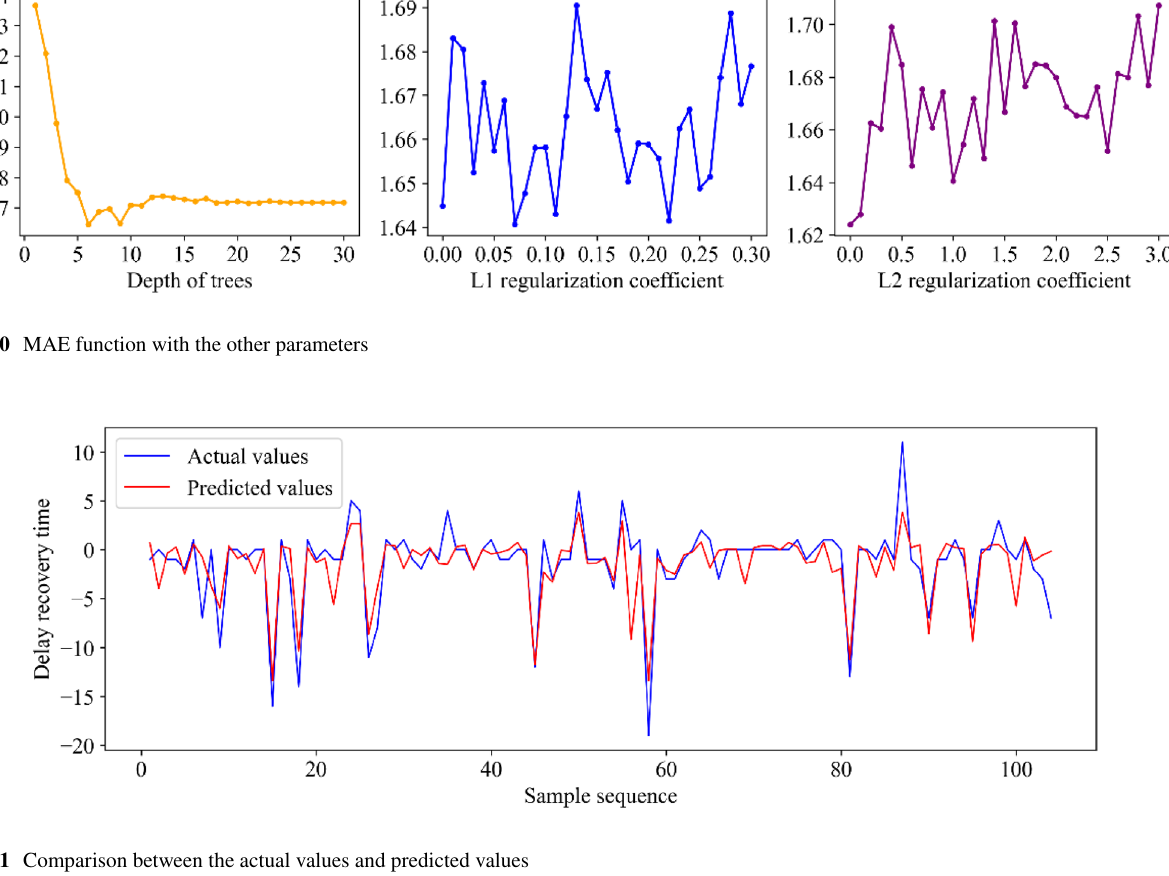
Fig. 11 Comparison between the actual values and predicted values